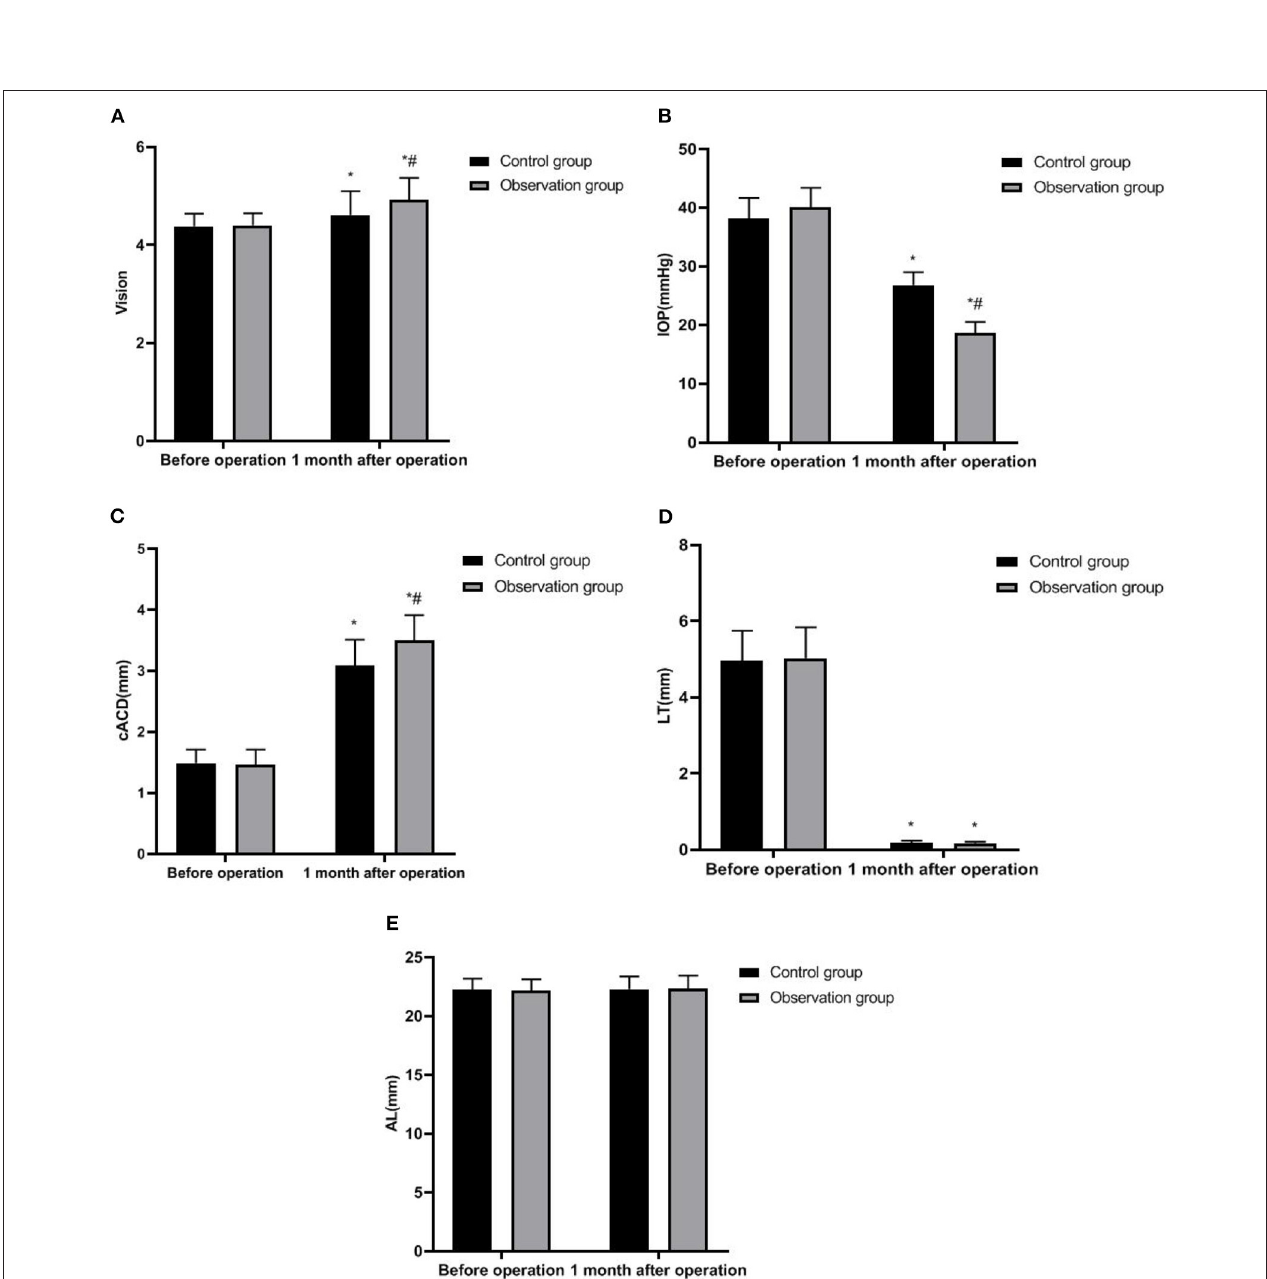
FIGURE 1 | Ophthalmic-related parameters of two groups. (A) Vision; (B) IOP; (C) cACD; (D) LT; and (E) AL. Compared with before operation, * P < 0.05; Compared with the control group, # P < 0.05.